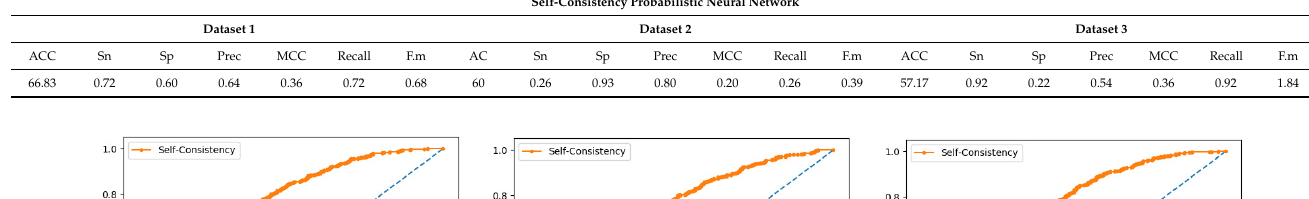
Table 7. Self-consistency test result for probabilistic neural network. Figure 10. Self- consistency Random Forest ROC curve.